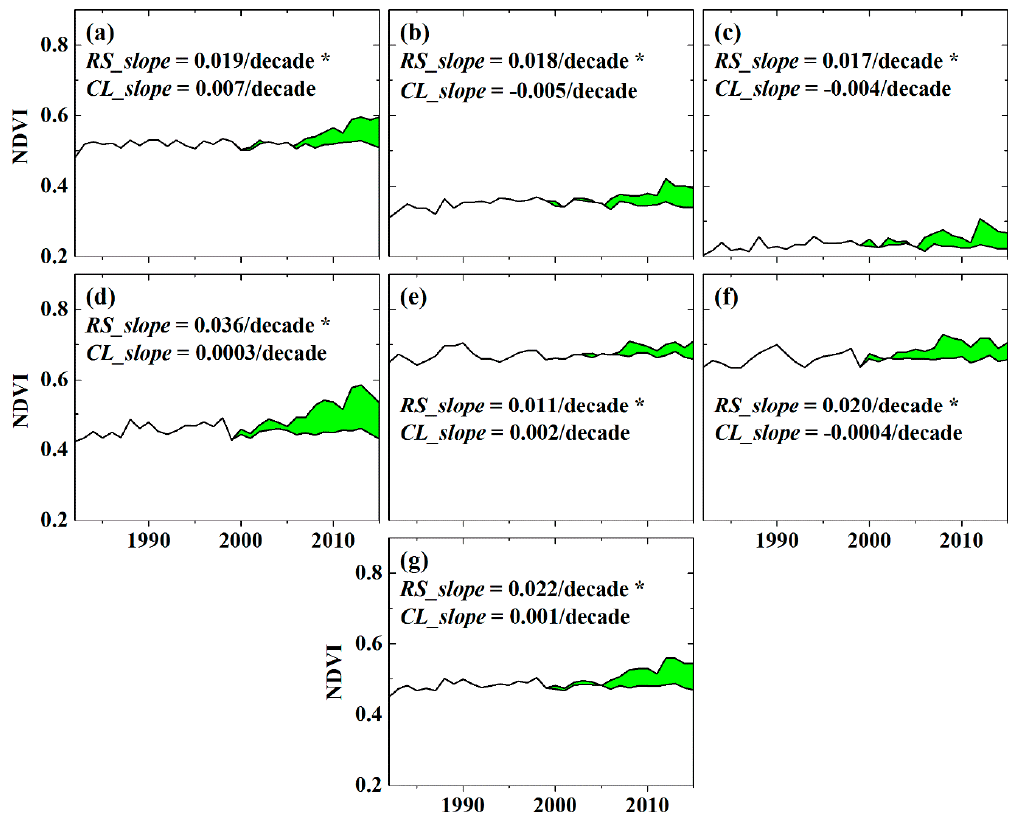
Figure 3. Trends of satellite-based observed NDVI (RS) and climate-derived NDVI (CL) during the period 1982–2015. Green shaded area represents human-induced NDVI, of which subfigures ( a ) the Loess gully region; ( b ) the irrigation region; ( c ) the sand and desert regions; ( d ) the Loess hilly and gully regions; ( e ) the valley plain region; ( f ) the earth-rock mountain region and ( g ) entire Loess Plateau present trends of RS and CL NDVI in each corresponding region, respectively. The symbol * represents the significance at the 95% statistical level ( p < 0.05).